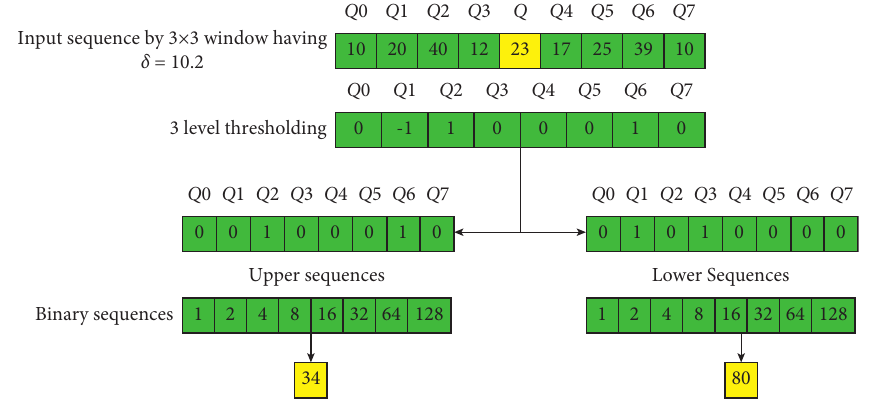
Figure 3: Extraction of upper and lower binary